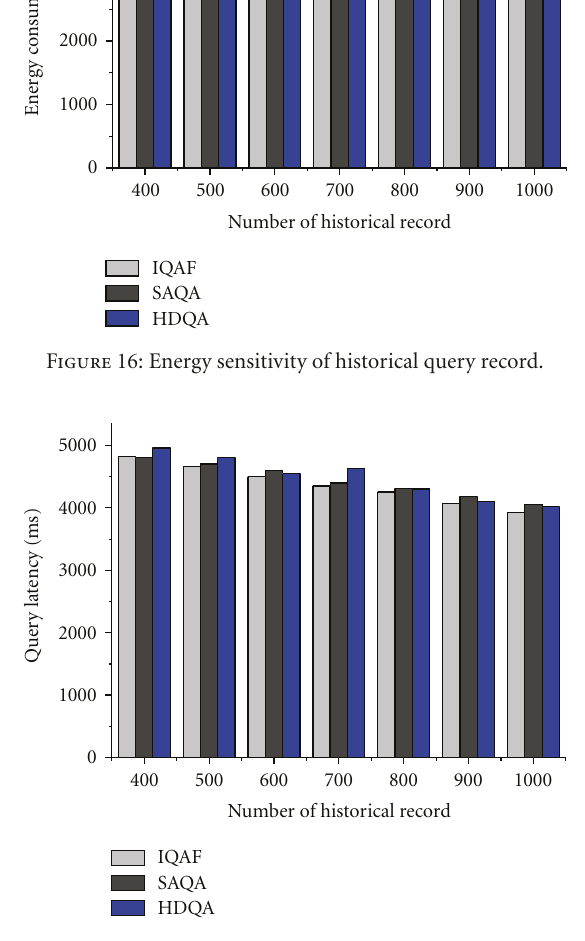
Figure 17: Query latency sensitivity of historical query